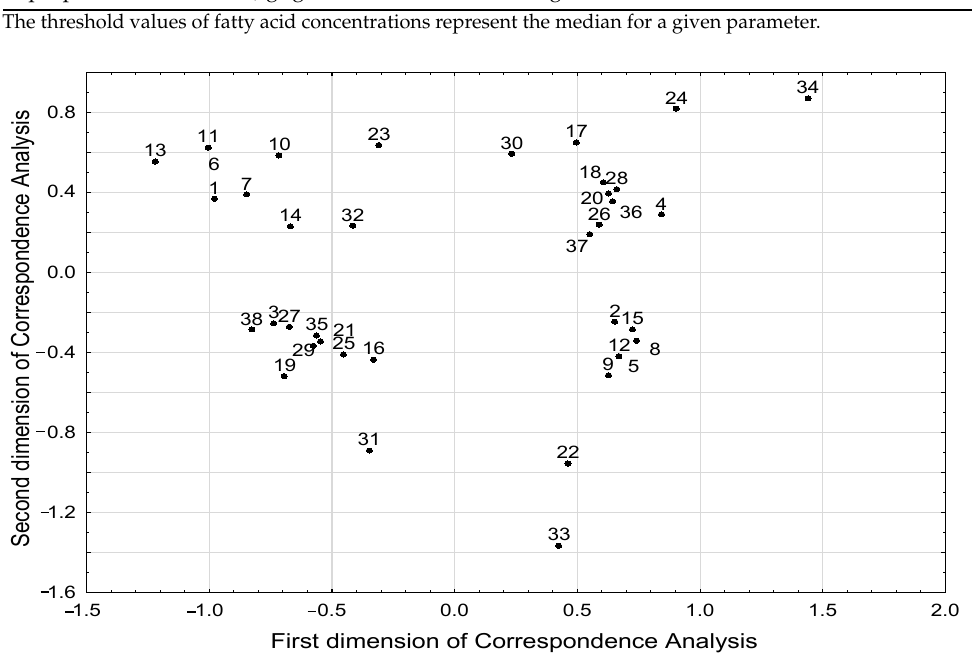
Figure 4. Structure of correlations between all parameters included in the correspondence analysis the projection of parameters in the space defined by first two dimensions of the correspondence